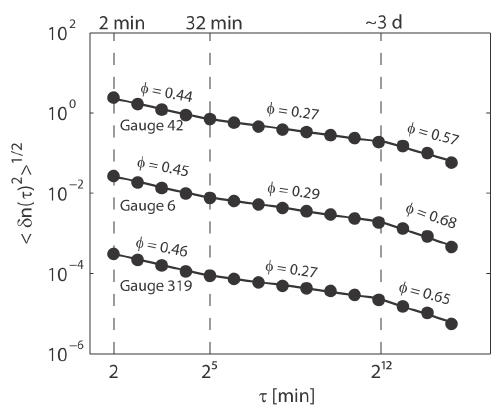
Fig. 5. Example of scaling regimes using the clustering exponent φ for gauges with IDs 42, 6, and 319 (shown in Fig. 1b). The slopes of the lines are estimates of φ in Eq. (4). Arbitrary units on the y- axis are used in order to display results from different gauges in the same graph.